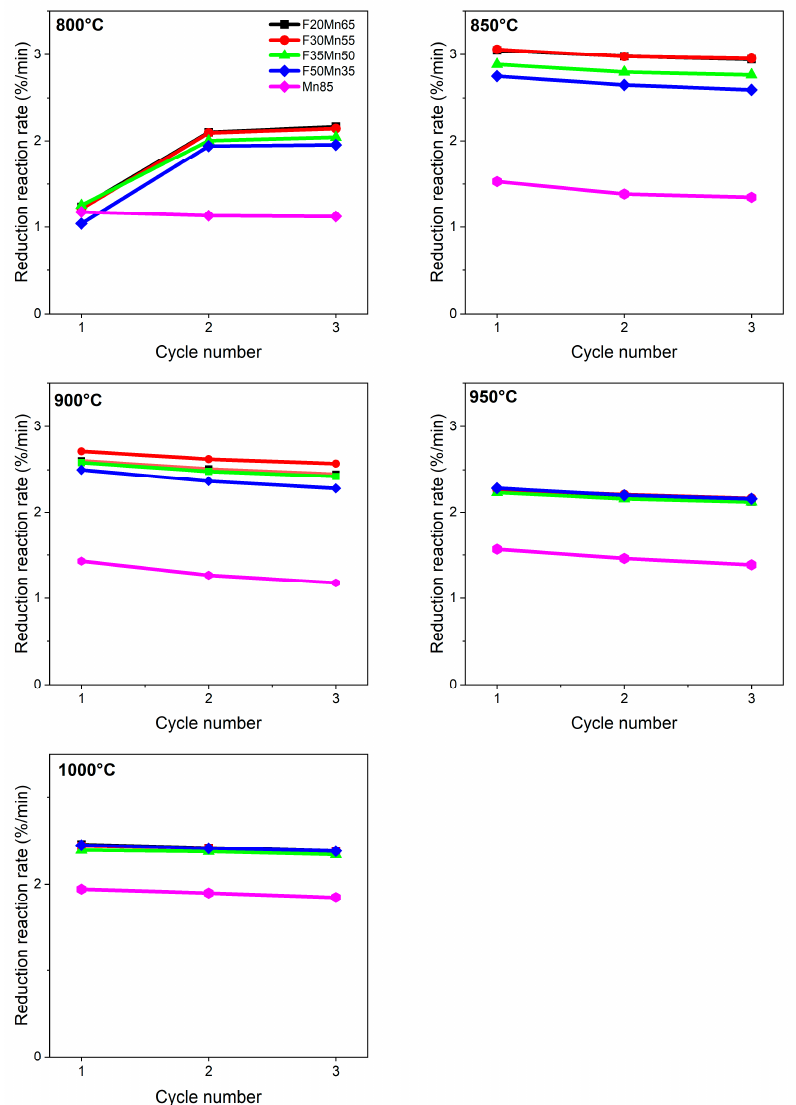
Figure 5. Reduction reaction rates for OCs versus cycle number at given temperatures (800, 850, 900, 950, 1000 °C). 950, 1000 ◦